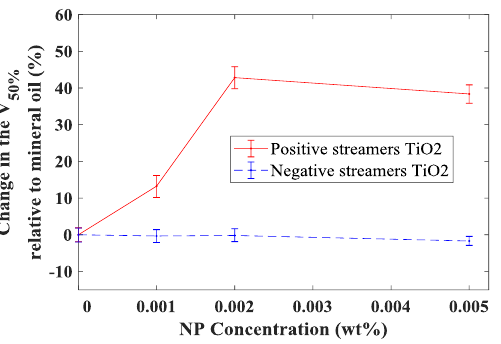
Figure 6. Change in 𝑉 50% of TiO 2 nanofluids relative to mineral oil as a function of mass fraction 𝑤 𝑖 .